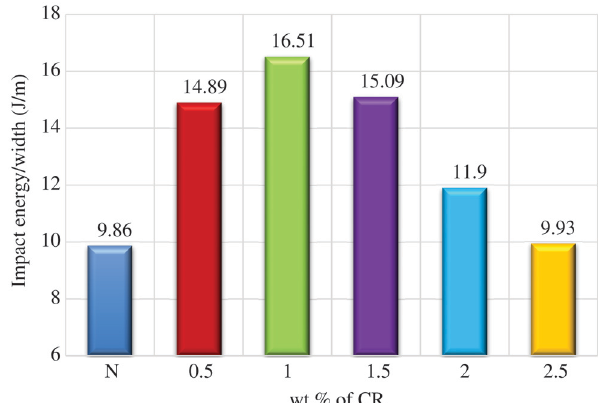
Figure 23: Variation of impact energy/width for various compositions of CFR.